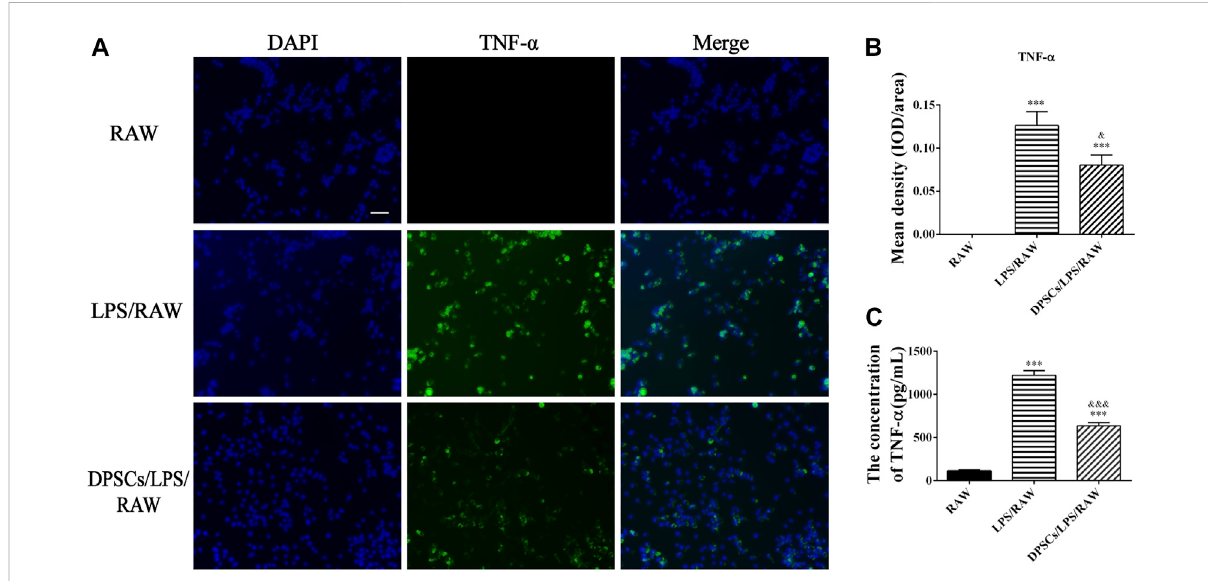
FIGURE 1 The expression of TNF- α in DPSCs co-cultured with RAW264.7 cells in vitro . (A) Immuno fl uorescence staining of TNF- α . Scale bar: 50 μ m. (B) Quanti fi cation of the fl uorescence intensity of TNF- α . *** p < .001 versus the RAW group. & p < .05 versus the LPS/RAW group. (C) Comparison of the supernatants TNF- α concentration among groups. *** p < .001 versus the RAW group. &&& p < .001 versus the LPS/RAW group.